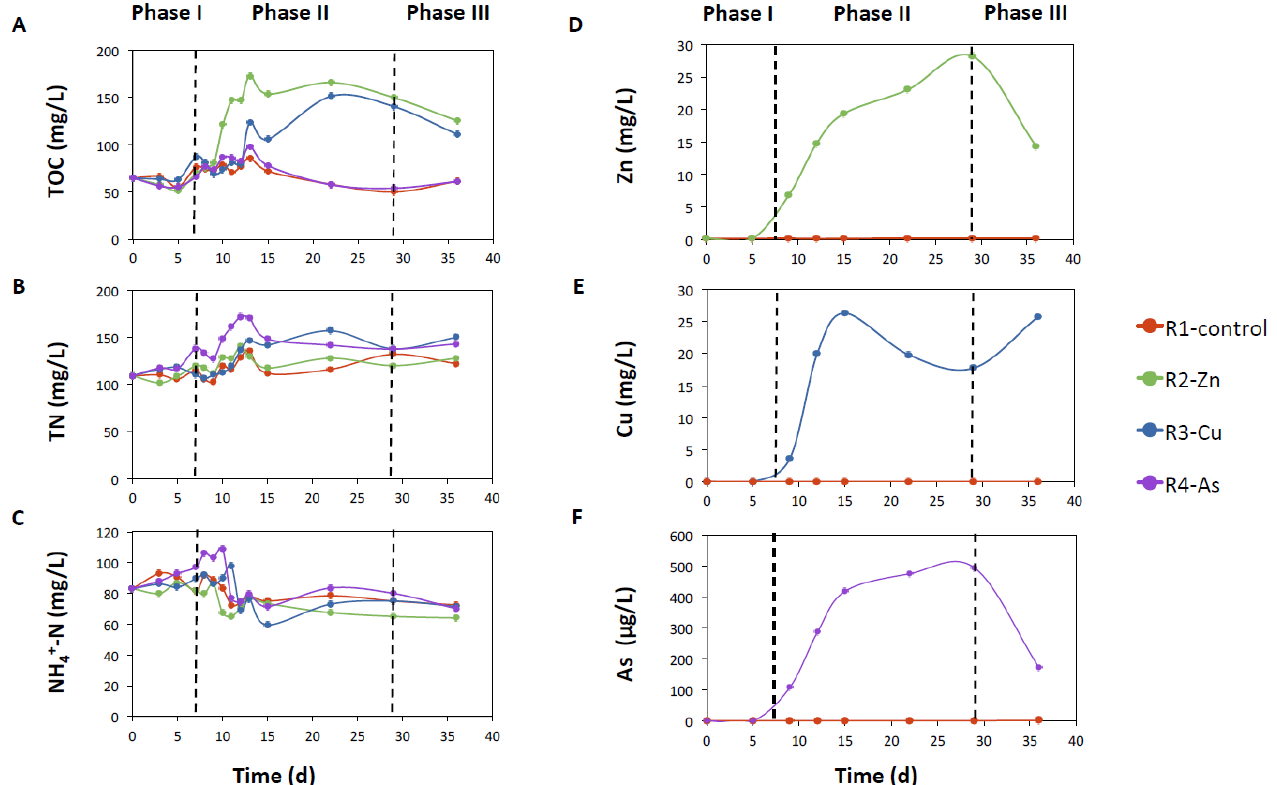
Figure 1. Concentrations of nutrients and Zn, Cu, and As in the effluent for the sets of experiment B in R1-control, R2-Zn, R3-Cu, and R4-As PBRs fed continuously at an HRT of 5 days. TOC ( A ), TN ( B ), NH 4+ -N ( C ), Zn ( D ), Cu ( E ), and As ( F ). Vertical dashed lines indicate the change of phase.